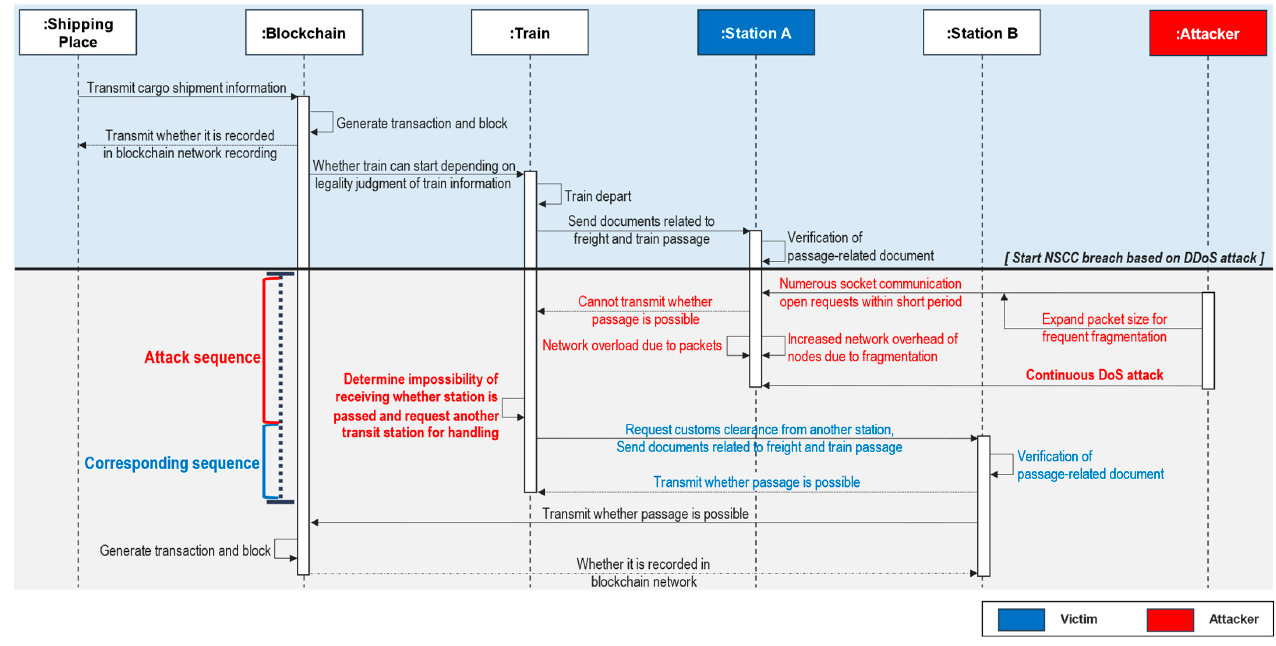
Figure 6. Attack sequence diagram using DoS.